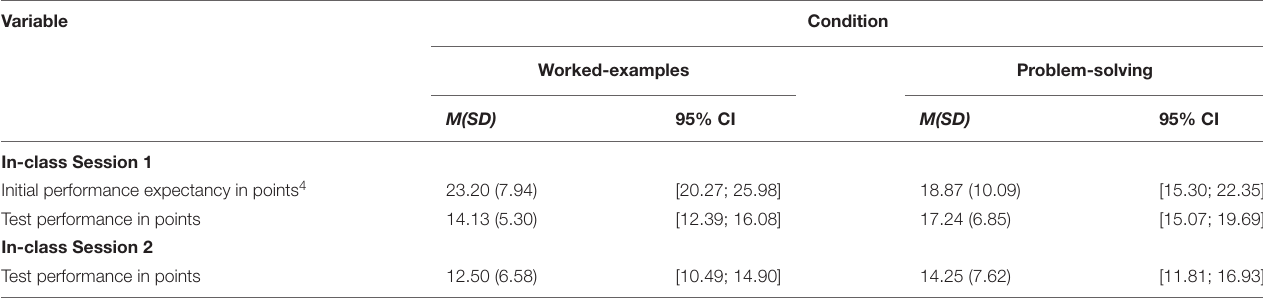
TABLE 1 | Descriptive statistics of the central variables.